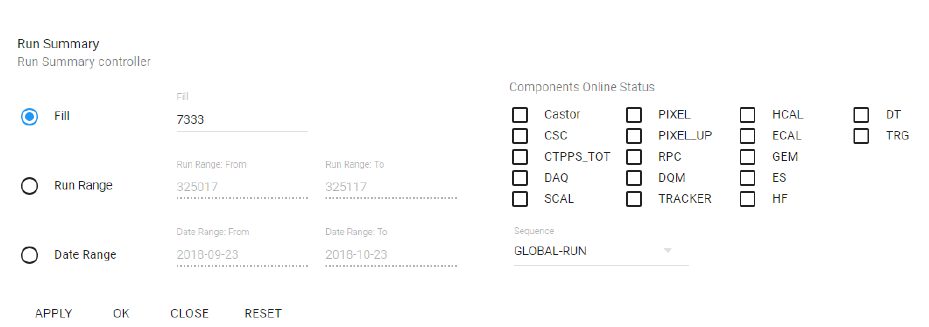
Figure 3. Run Summary controller. Selectors: LHC Fill, CMS Run range, date range,